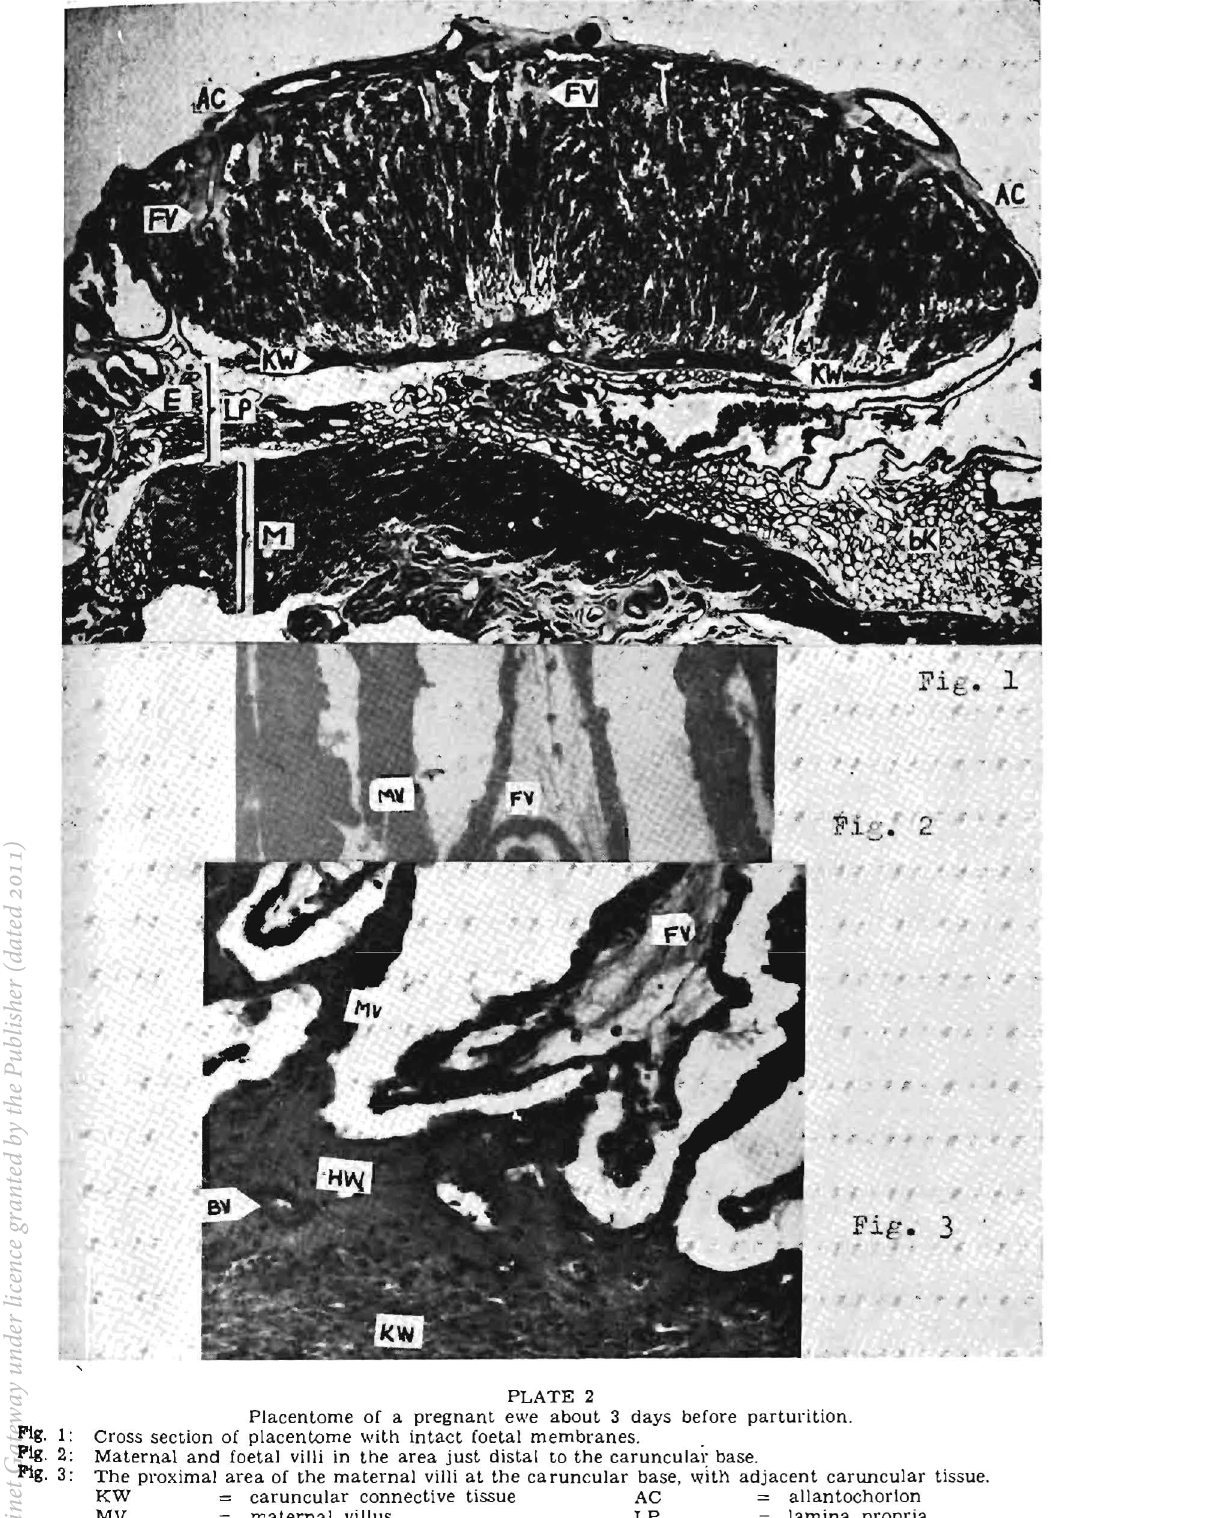
PLATE 2 Placentome of a pregnant ewe about 3 days before parturition. Cross section of placentome with intact foetal membranes. Maternal and foetal villi in the area just distal to the carunculai· base. The proximal area of the maternal villi at the ca runcular base, with adjacent carunculaI'